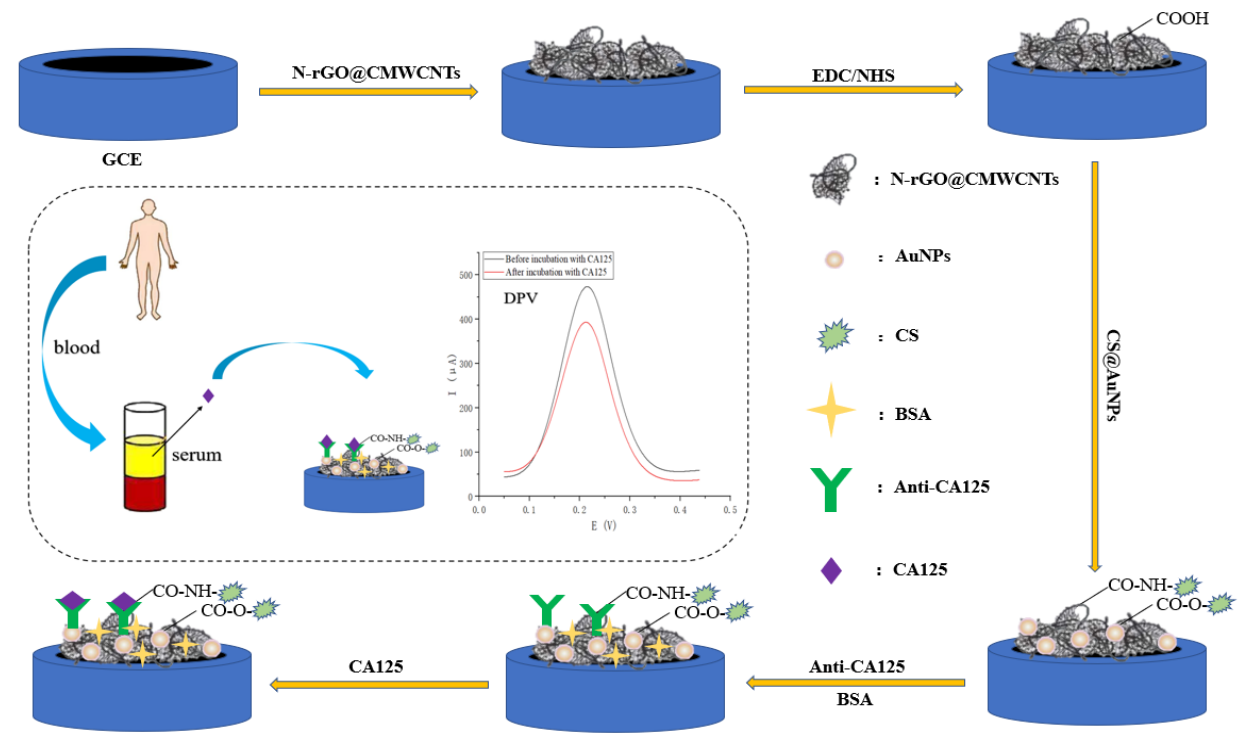
Figure 1. Construction of immunosensor.